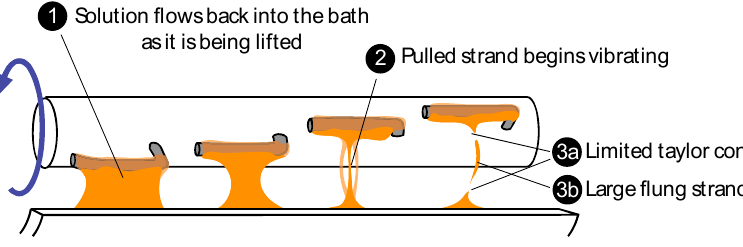
Figure 5. A diagram illustrating the assisted formation of Taylor cones from a saguaro electrode. The solution is indicated in orange. The saguaro electrode is detailed later and appears in Figure 4, the bottom of Figure 6, and in Figure A4. (1) As the arms are removed from the bath, the majority of the solution will flow from the arm. (2) The flowing fluid thins and is stretched into a strand, as they are further pulled, they begin to vibrate due to imbalances in the electric field. (3a) After the strand breaks, Taylor cones are formed on the broken ends, and electrospinning jets are observed. (3b) Occasionally, as stretched strand would break, the electric fields would eject large pieces or globs them towards the